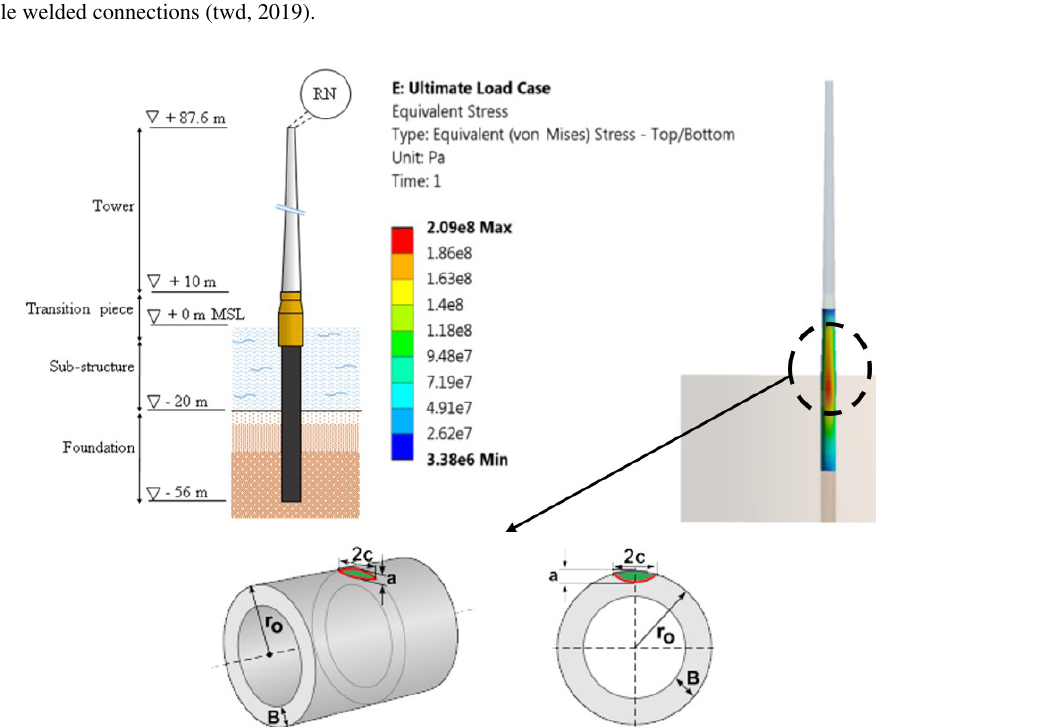
Figure 19. The case study structure diagrams and FEA contour plots for the support